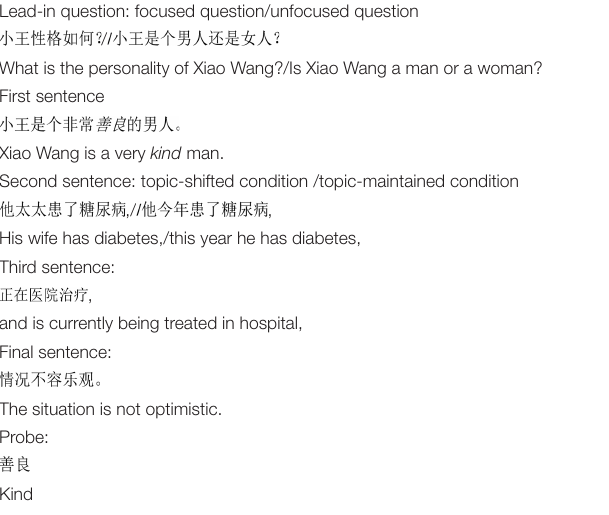
TABLE 1 | Example stimuli used in Experiment